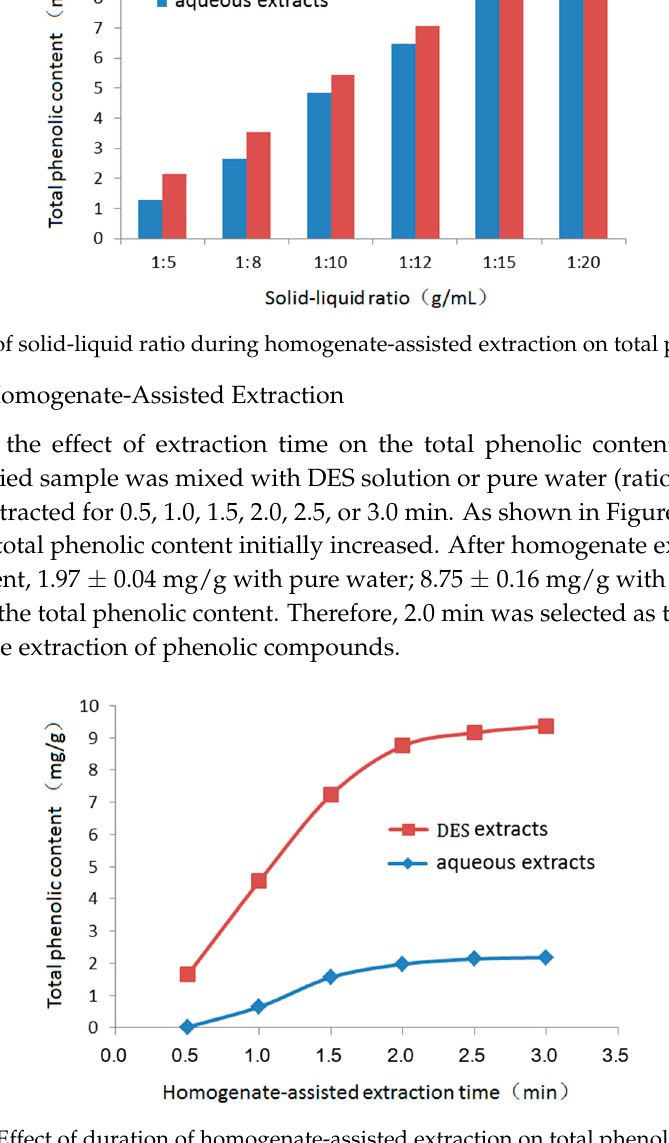
Figure 4. Effect of duration of homogenate-assisted extraction on total phenolic content.